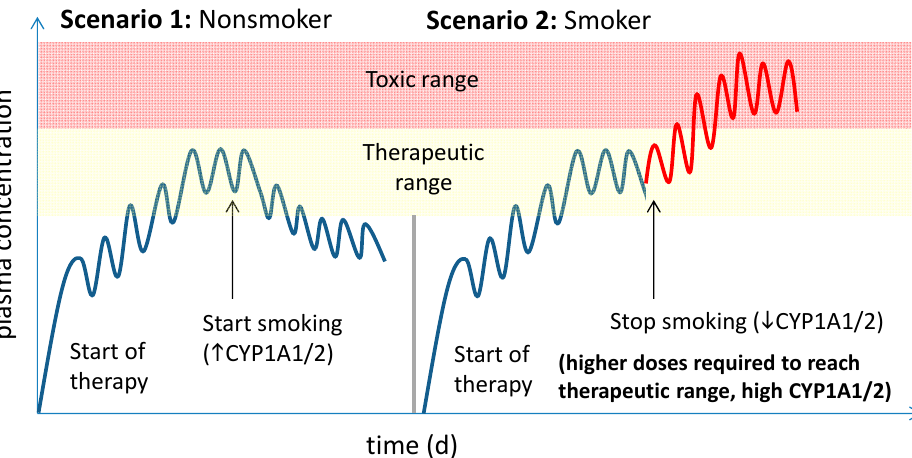
Figure 2. Schematic overview of potential interaction scenarios of tobacco smoking. In scenario 1, a nonsmoker reaches the steady state conditions of a certain CYP1A1/2 substrate after 5 – 6 half-lives using standard doses. After start smoking, CYP1A enzymes are significantly induced in intestine and liver resulting in increased drug clearance and decreasing plasma levels of the respective drug. In scenario 2, a smoker, who has already substantially higher expression and metabolic activity of CYP1A1/2, requires significantly higher doses to reach the therapeutic range. After stopping smoking, CYP1A1/2 will gradually return to the native expression levels, while the daily drug doses are not adjusted, which results in markedly increased and potentially toxic plasma concentrations.